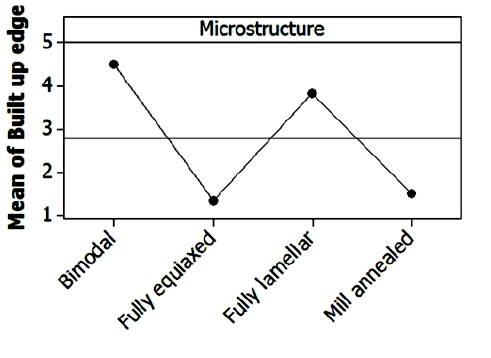
Figure 8. Main effect plot for the tool built up edge index based on SEM images. 1 = poor; 5 =